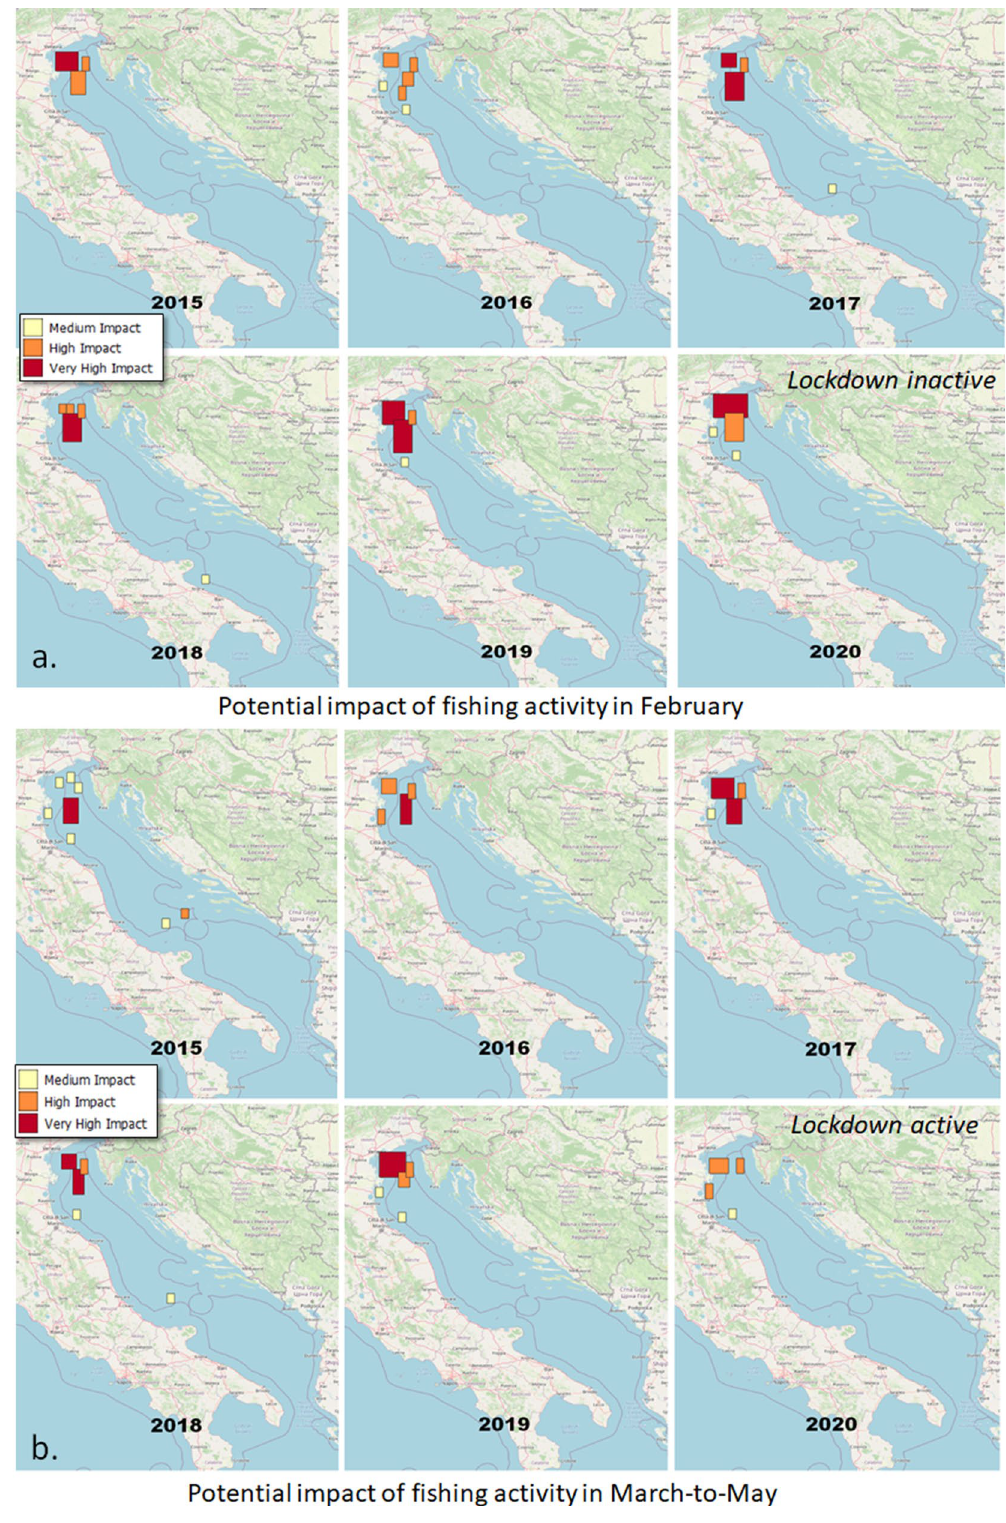
Figure 5. Spatial distribution of the total potential impact of fishing activities on endangered, threatened and protected (ETP) species in ( a ) February and ( b ) March-to-May (aggregated). Maps were created with